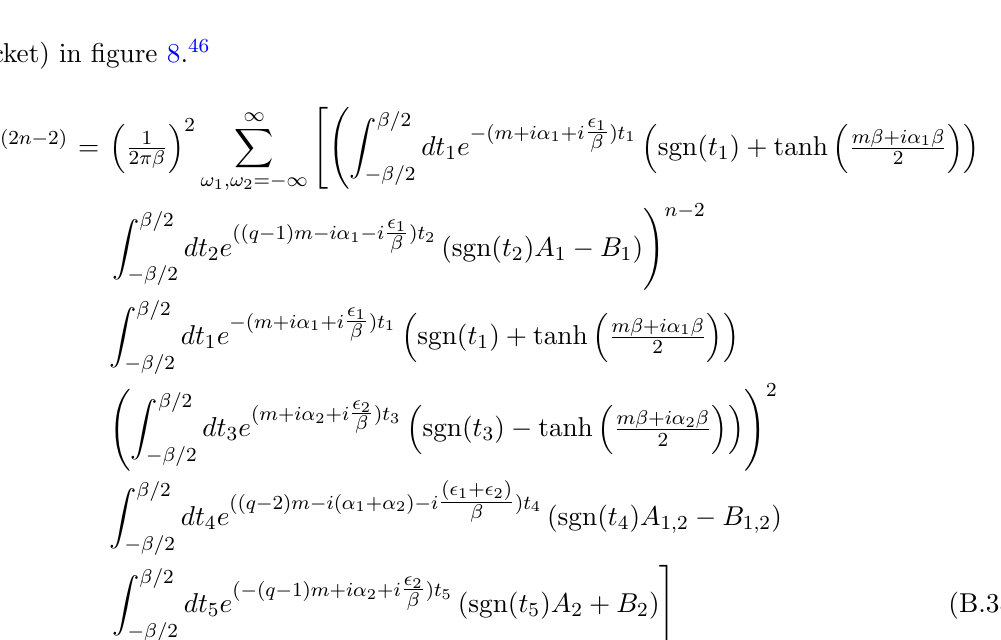
Figure 7 . Subleading